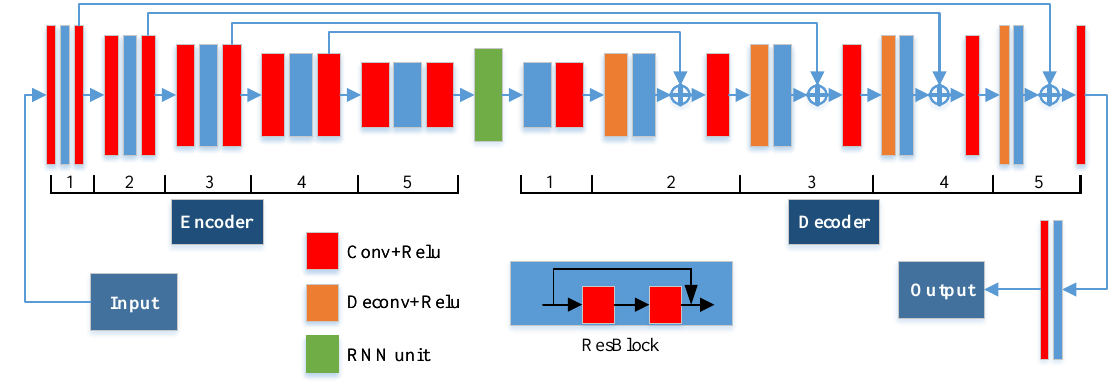
Figure 7. Detailed structure of each